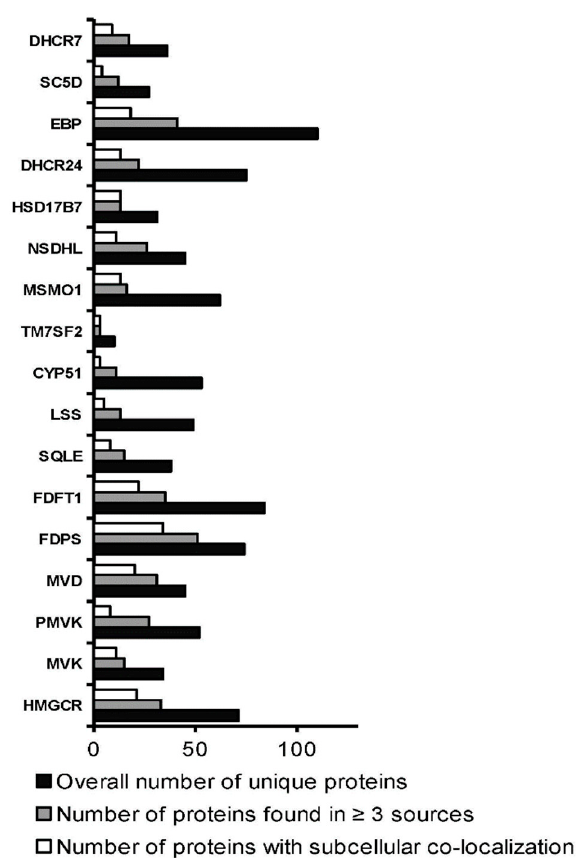
Figure 3. Selection rounds of found protein partners.